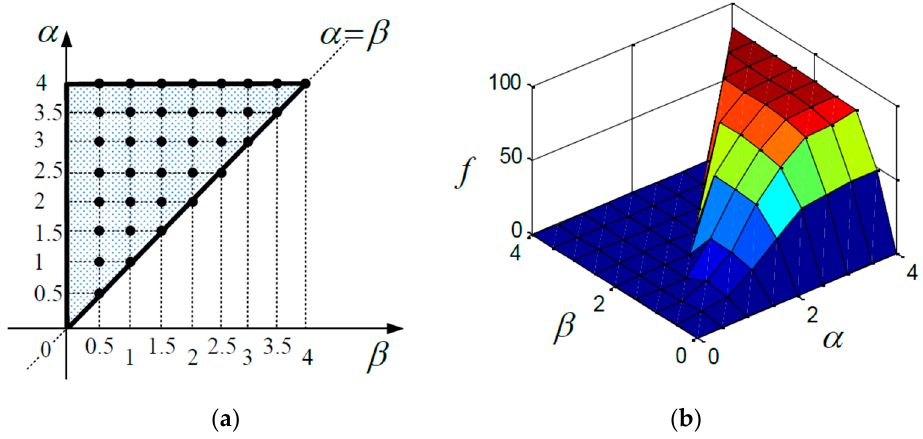
Figure 7. Experimental data recorded for the numerical calculation ( a ) Set points within the working area for data capture; ( b ) the output value for each point.